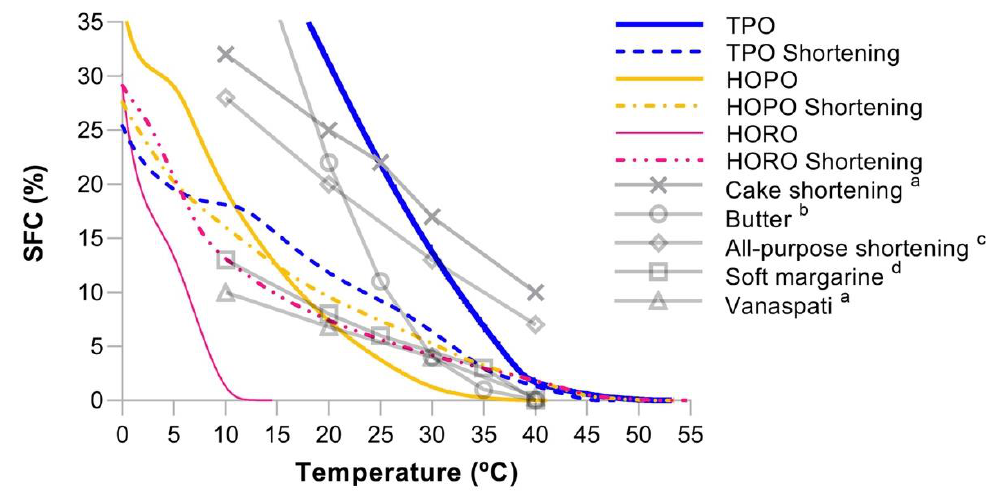
Figure 4. Solid Fat Content as calculated using DSC measurements for TPO, HOPO and HORO shortenings/oils. Literature SFC for commonly used baking fats are provided for comparison purposes and are represented as greyed values. Sources: a [55], b [56], c [13], d [4]. Abbreviation—S: Short- ening.